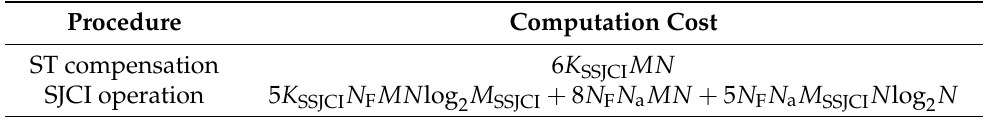
Table 2. Computation costs of the SSJCI